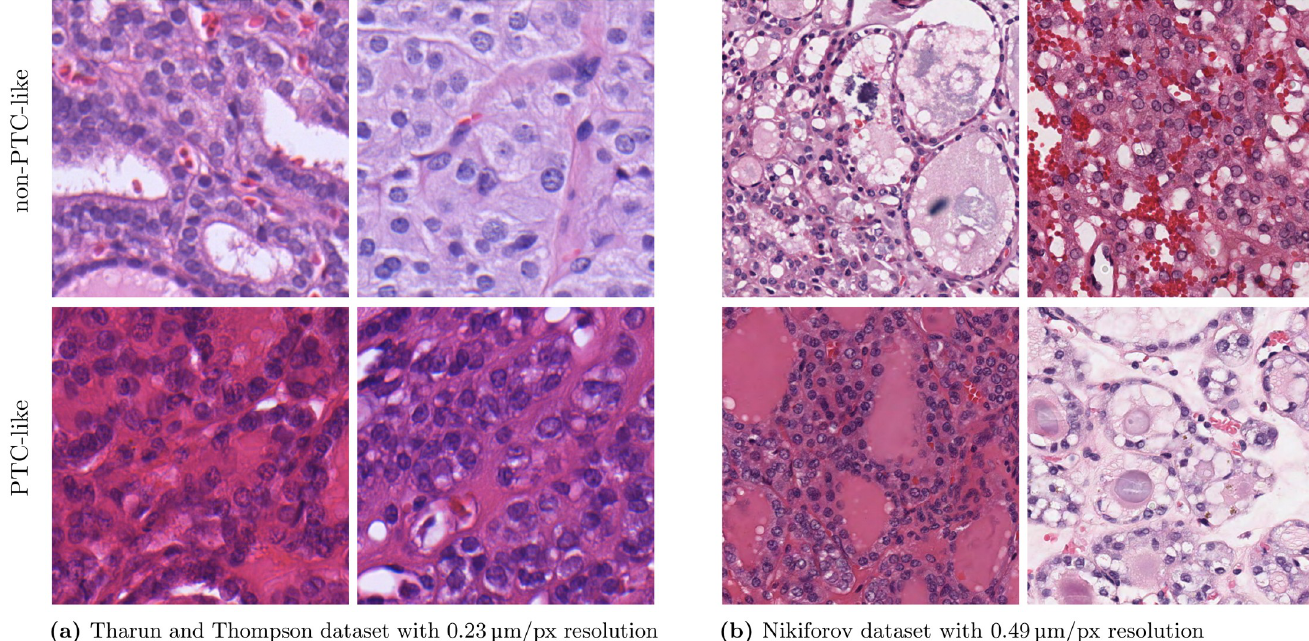
Fig 1. Example thyroid gland tumor images from the Tharun and Thompson dataset and the Nikiforov dataset. The images are cropped to 512 × 512 px. The upper row shows non-PTC-like samples and the lower row shows PTC-like samples. A high-resolution version is available in S1 Fig.